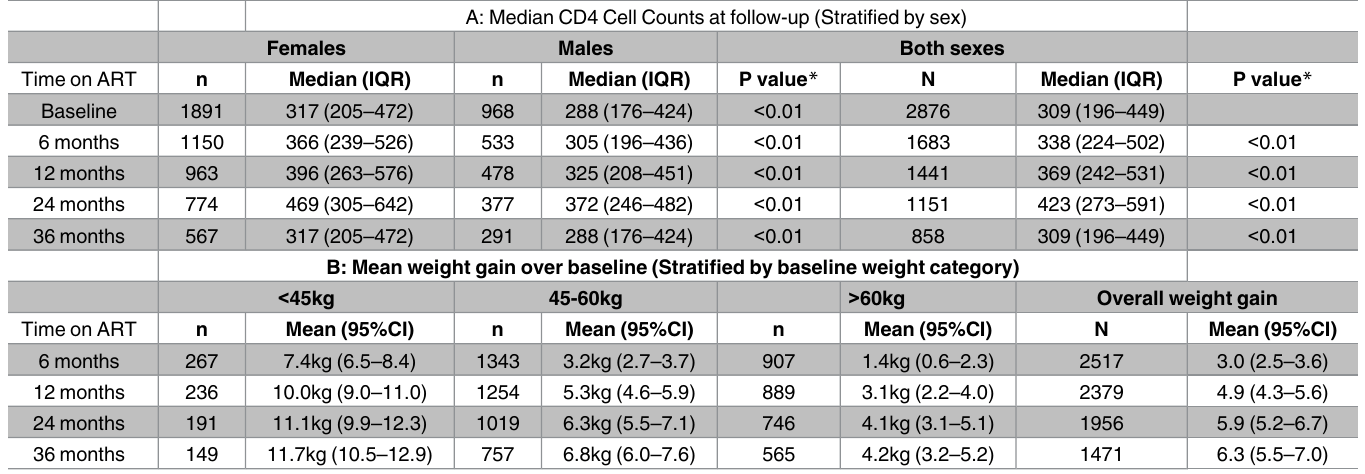
Table 5. Weight and CD4 Changes with duration on ART (weighted original